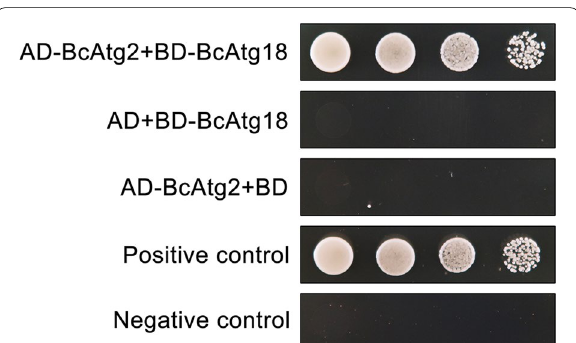
Fig. 8 BcAtg2 interacts with BcAtg18. Growth phenotypes of yeast cells co-transformed with the indicated combinations of bait and prey plasmids and incubated on SD-Leu-Trp-His medium. The combination of pGADT7/pGBKT7-53 was used as a positive control, and pGADT7/pGBKT7-Lam as a negative